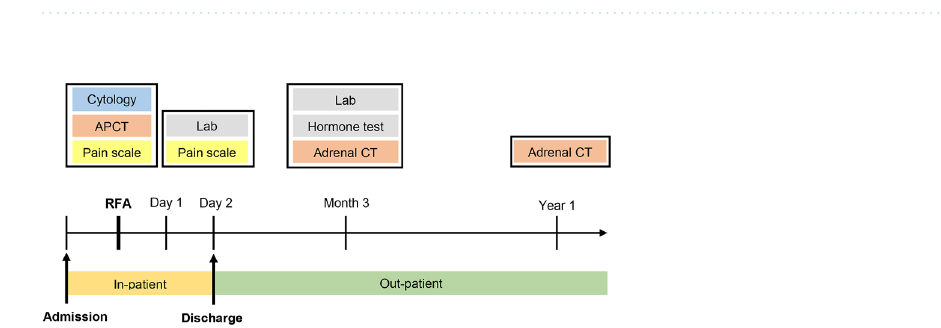
Table 1. Definitions of responses to treatment.